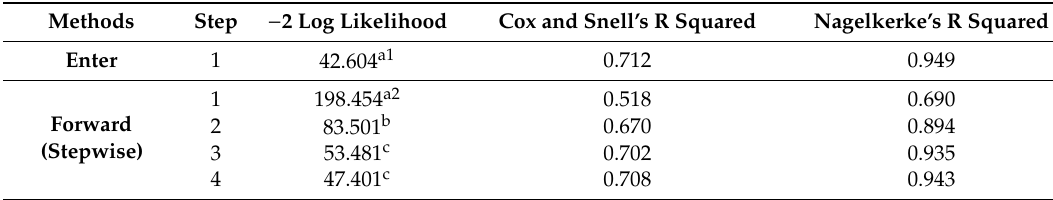
Table 6. LR model